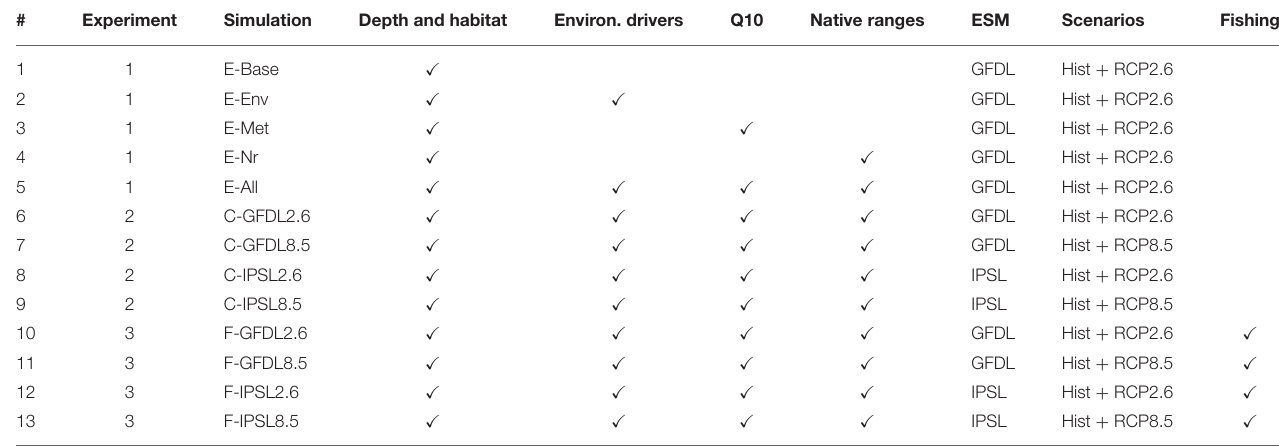
TABLE 1 | EcoOcean experiments and simulations used to test the relative influence of alternative configurations of the ecological model (experiment 1, simulations 1–5), ESM and RCP scenarios (experiment 2, simulations 6–9), and the additional impact of fishing (experiment 3, simulations 10–13) on projected results. # Experiment